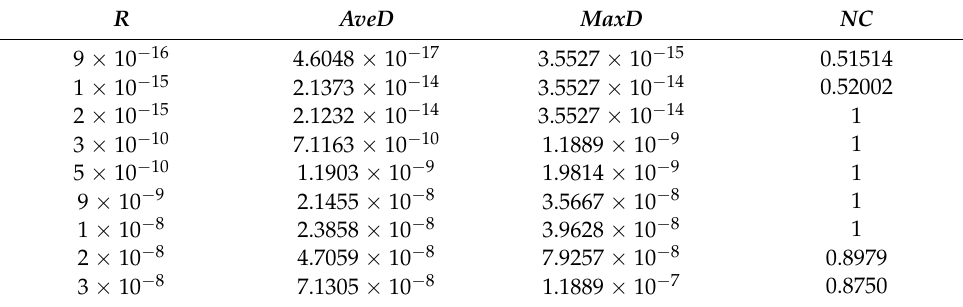
Table 6. The relationship between AveD , MaxD , NC and R ( n = 8).